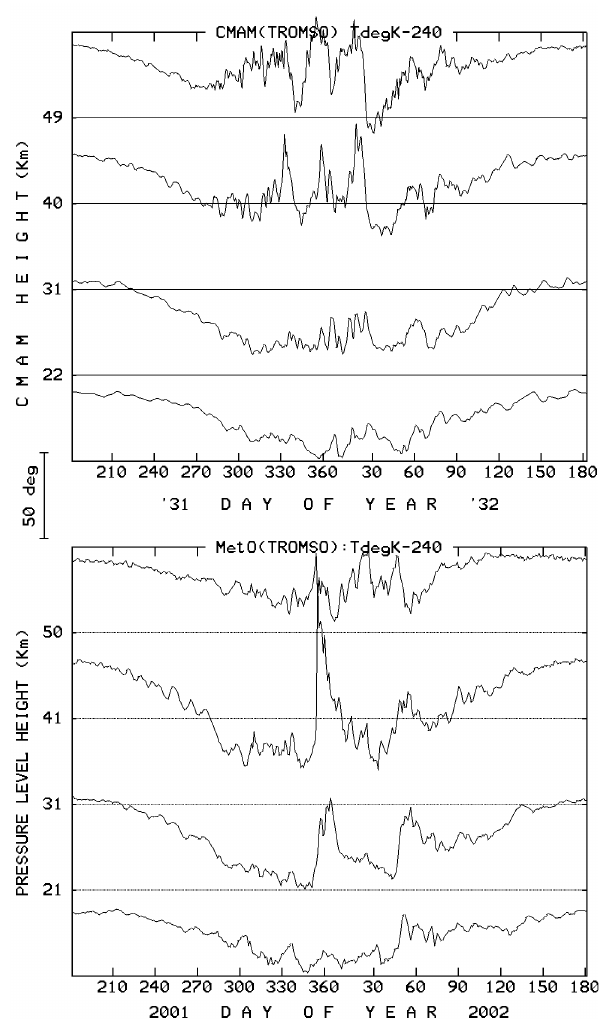
Fig. 1. Time sequences of stratospheric temperature data from the United Kingdom Meteorological Office (MetO, or sometimes UKMO) and the CMAM model. The location is Tromsø (70 ◦ N) and the years are 2001/02 and model-years